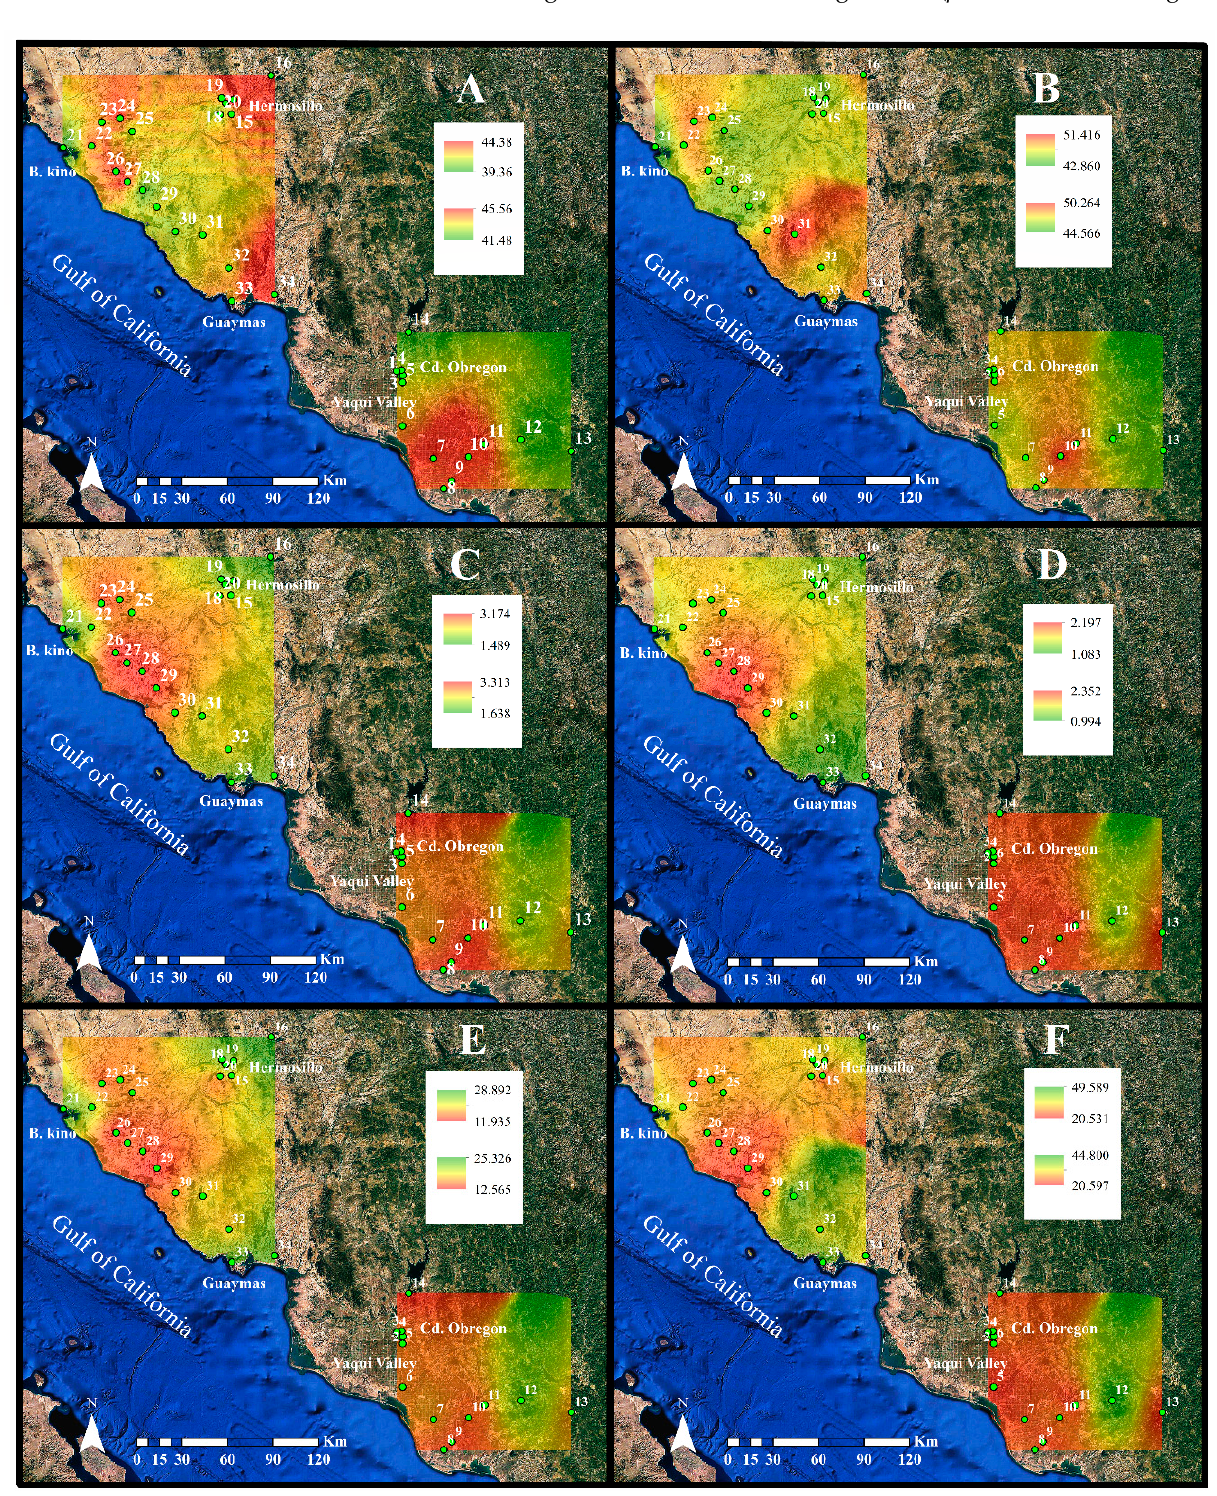
Figure 3. Spatial distribution for the elemental composition for buffelgrass in Sonora, Mexico. Carbon content (C%, dry weight) for ( A ) leaves and ( B ) seeds, nitrogen content (N%, dry weight) for ( C ) leaves and ( D ) seeds, and the C:N ratio for ( E ) leaves and ( F ) fascicles. Image data: Google Earth; date: 20 April